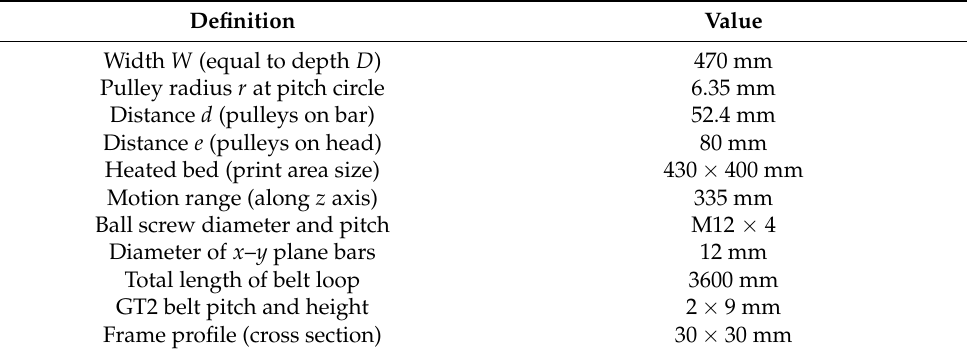
Table 2. Main design parameters for the